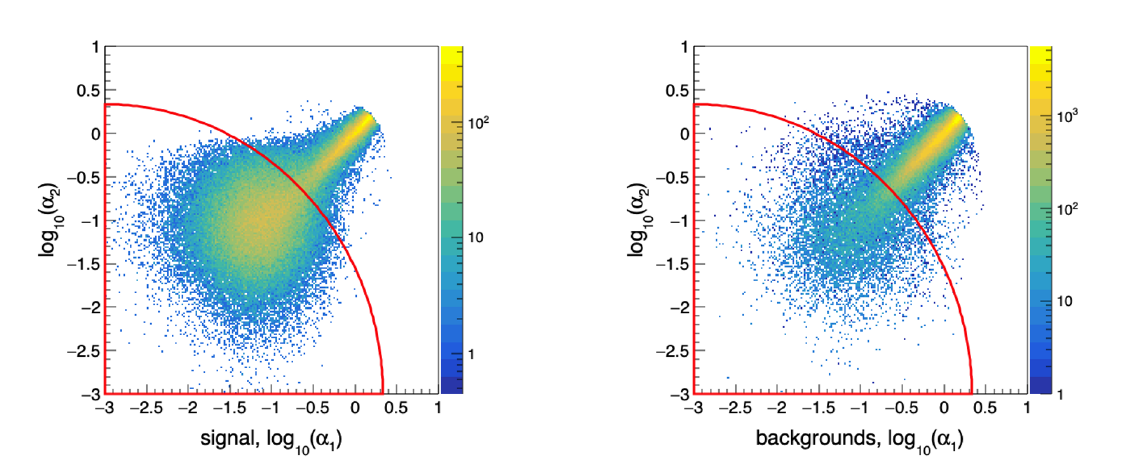
Figure 14 . After the whole event selection in table 2, the distributions of log 10 ( α 1 ) versus log 10 ( α 2 ) for signal and background are shown in the left and right plots,